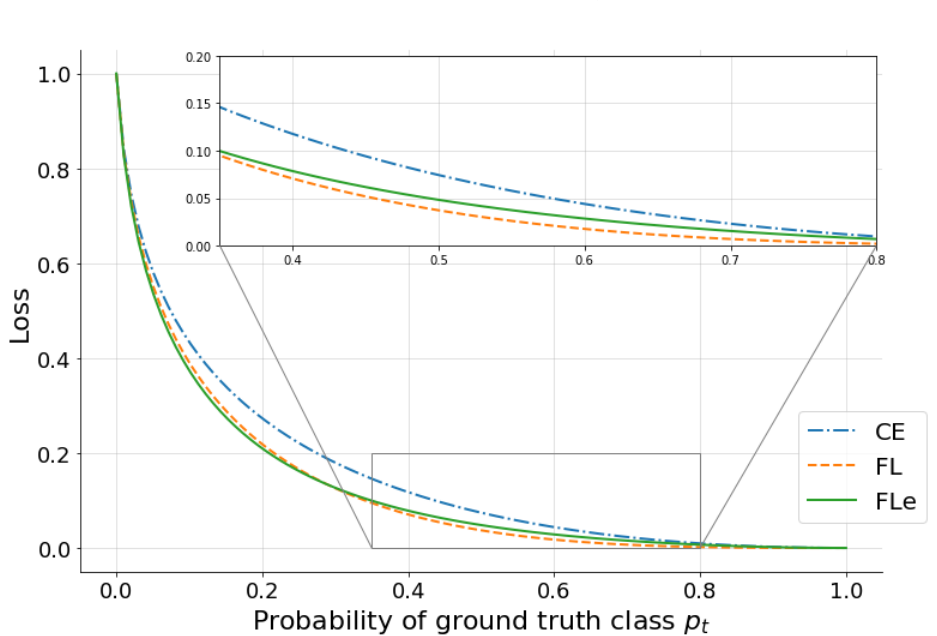
Figure A1. Our modified Focal Loss function (FL e ) compared with FL ( γ = 2), and cross entropy (CE). FL e introduces an adaptive exponent to the original FL [21]. This effectively changes the underlying distribution of classes in regards to their APs and promotes some of the poorly classified classes to a better score while preserving the performance of well-classified